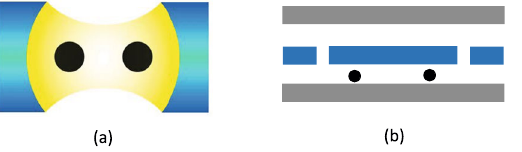
Figure 1. ( a ) Setup for two superconducting transmon qudits embedded in a 3D cavity. ( b ) Setup for two superconducting transmon qudits coupled to a 1D transmission line resonator. A dark dot represents a superconducting transmon